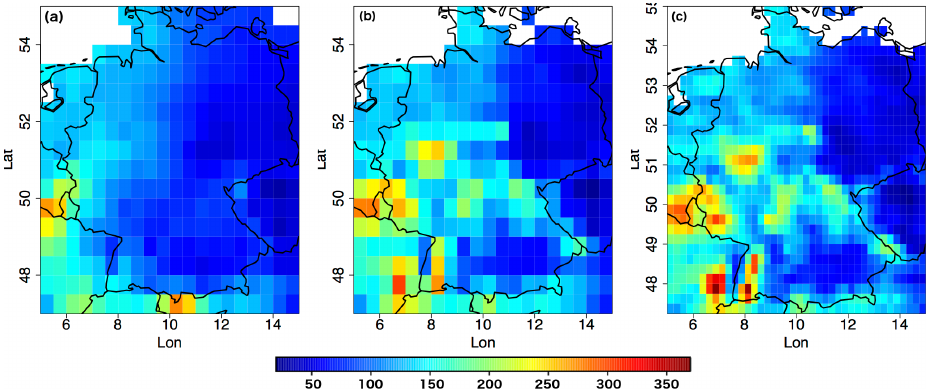
Figure 3. Gridded total precipitation observations for January 1995: (a) CRU data (0.5 ◦ × 0.5 ◦ ), (b) E-OBS data upscaled to 0.5 ◦ × 0.5 ◦ , and (c) E-OBS data with original resolution (0.25 ◦ × 0.25 ◦ ).